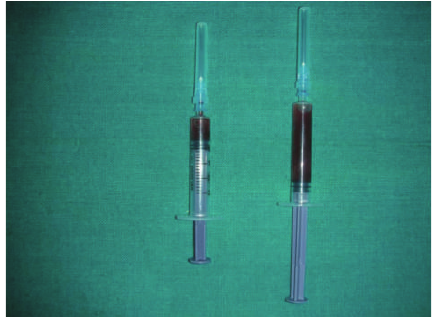
Figure 3: Serosanguinous aspirate with blood.